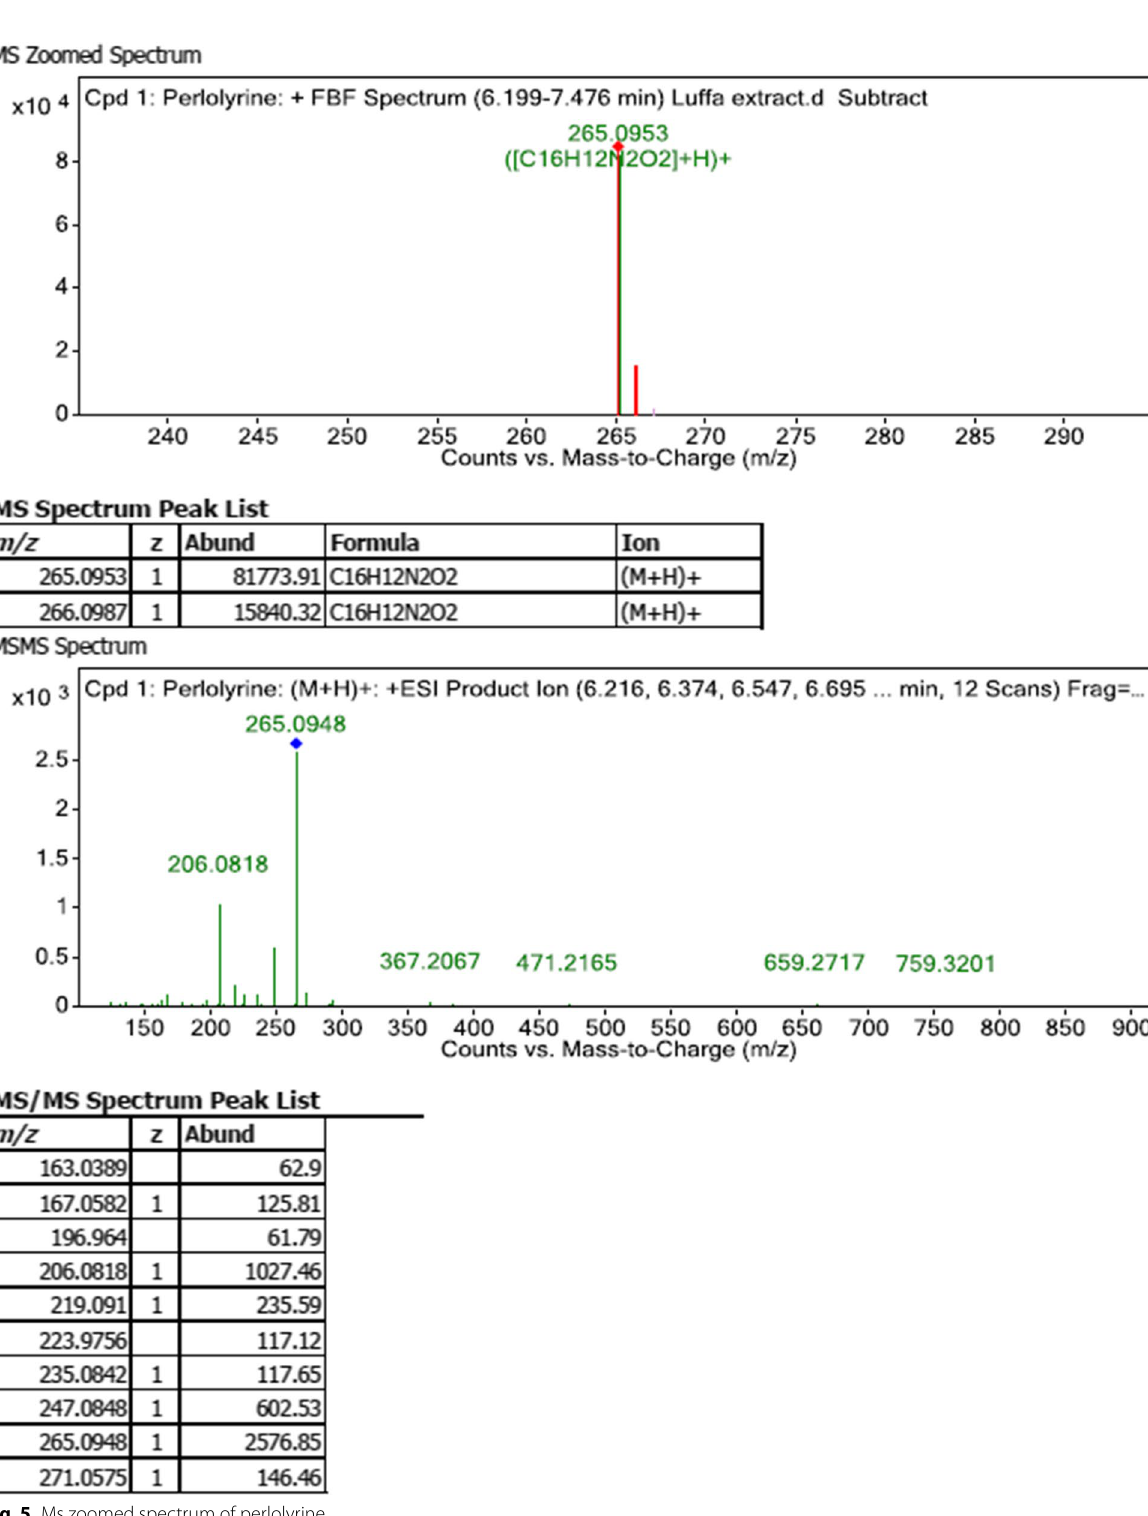
Fig. 5 Ms zoomed spectrum of